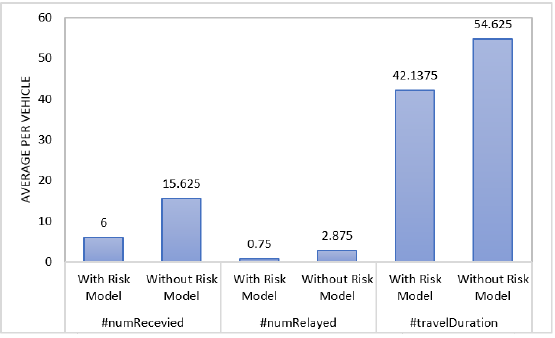
Figure 8. Average simulation-based results per